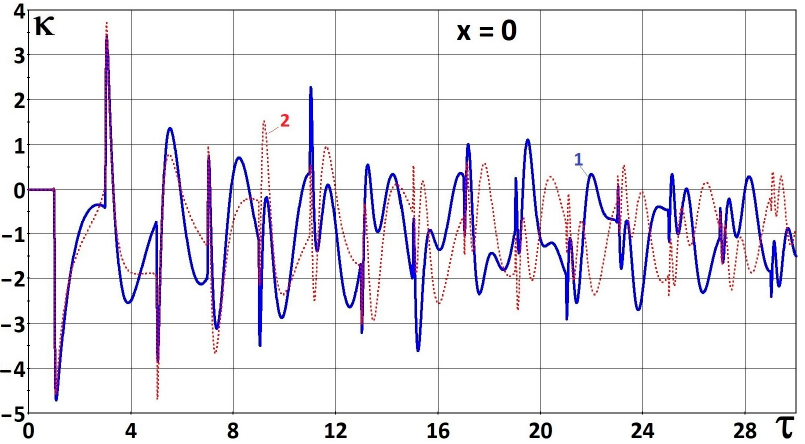
Figure 4. Relative stress–time history at x = 0 for the case of an exponential decrease in FGM properties with increasing x (curve 1) and linear decrease (curve 2).